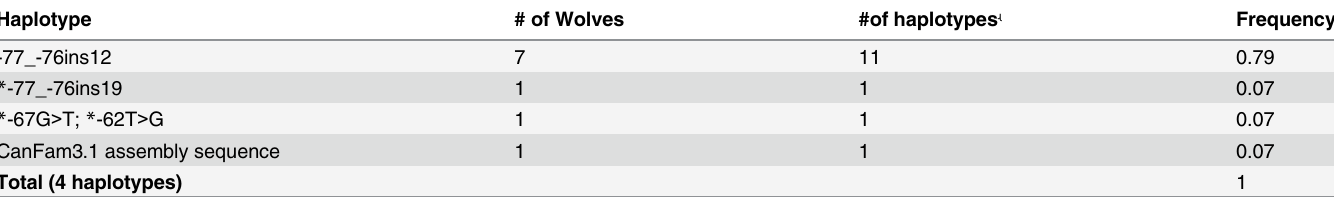
Table 3. 5 ’ UTR Cox-2 variants found in 7 Alaskan gray